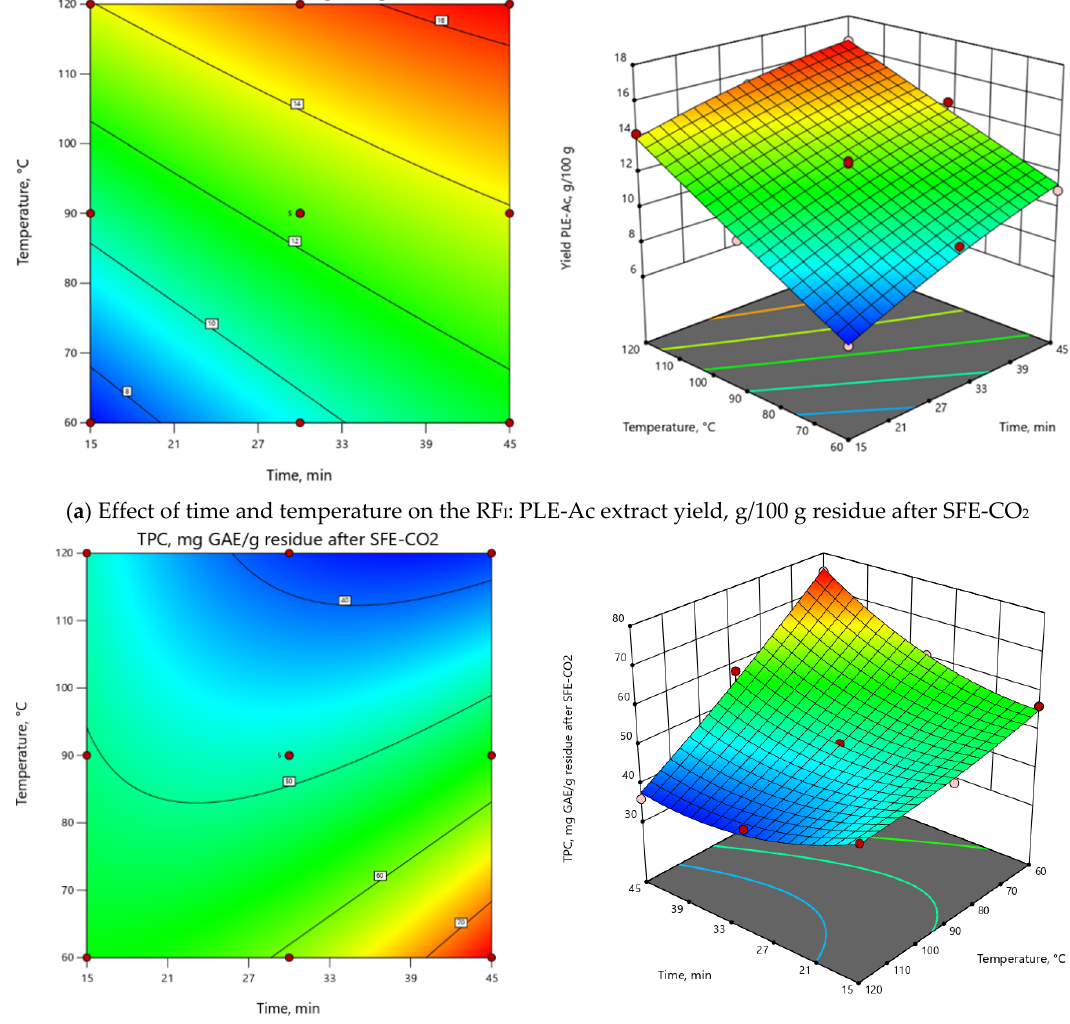
Figure 2. Response surface 3D and 2D plots showing the effects of independent variables on the selected response factors: ( a ) D. fruticosa leaves PLE-Ac extract yield (g/100 g residue after SFE-CO 2 ); ( b ) total phenolic content (TPC, mg GAE/g residue after SFE-CO 2 ).